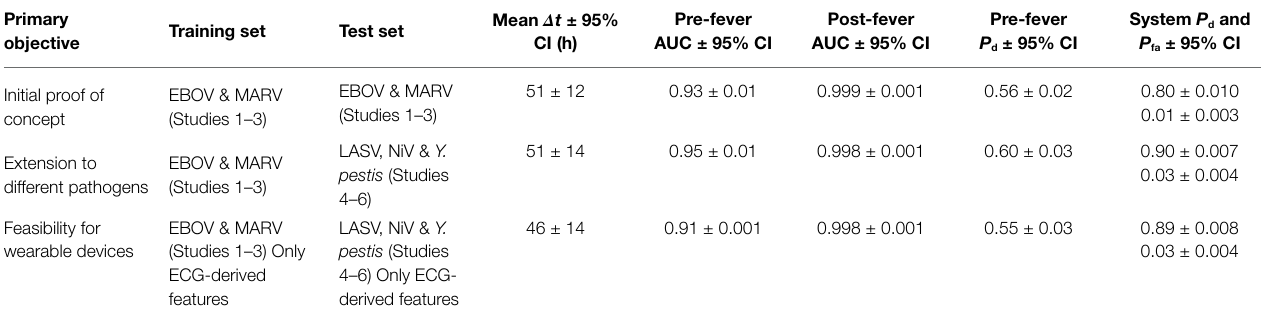
FIGURE 8 | Performance measures from independent data set validations. ROC and detectability vs. time before fever curves were using (A) all available features from the implantable telemetry system ( Table 2 ), and (B) using only features derived from the ECG waveform. Even when all temperature, blood pressure, and respiratory features are excluded, algorithm performance drops only slightly from Δ t mean = 51 to 46 h, and from pre-fever AUC = 0.95 to 0.91. TABLE 5 | System performance metrics for the three validation